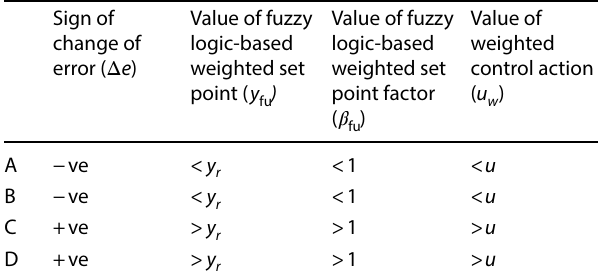
Table 2 Meaning of the linguistic variables used in fuzzy inference